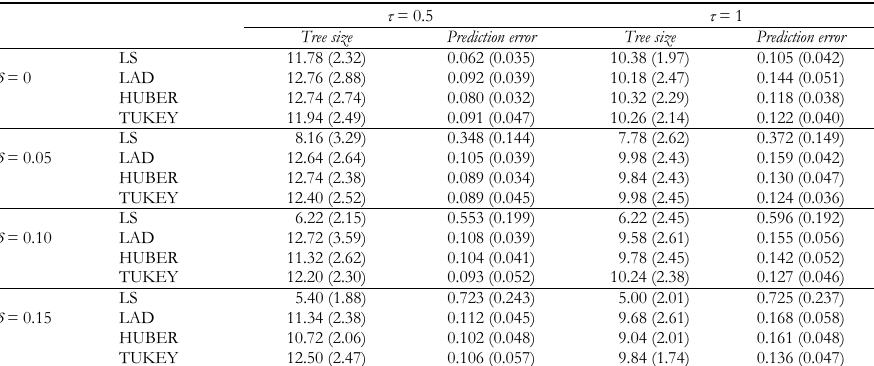
Mean and standard deviation (in brackets) of the tree sizes and the prediction errors over 50